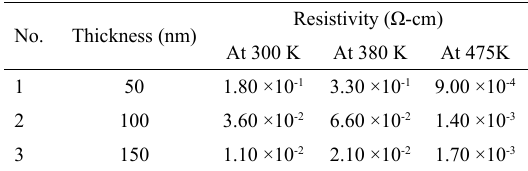
Table 1: Dependence of resistivity on the films thickness at various temperatures. No. Thickness (nm)